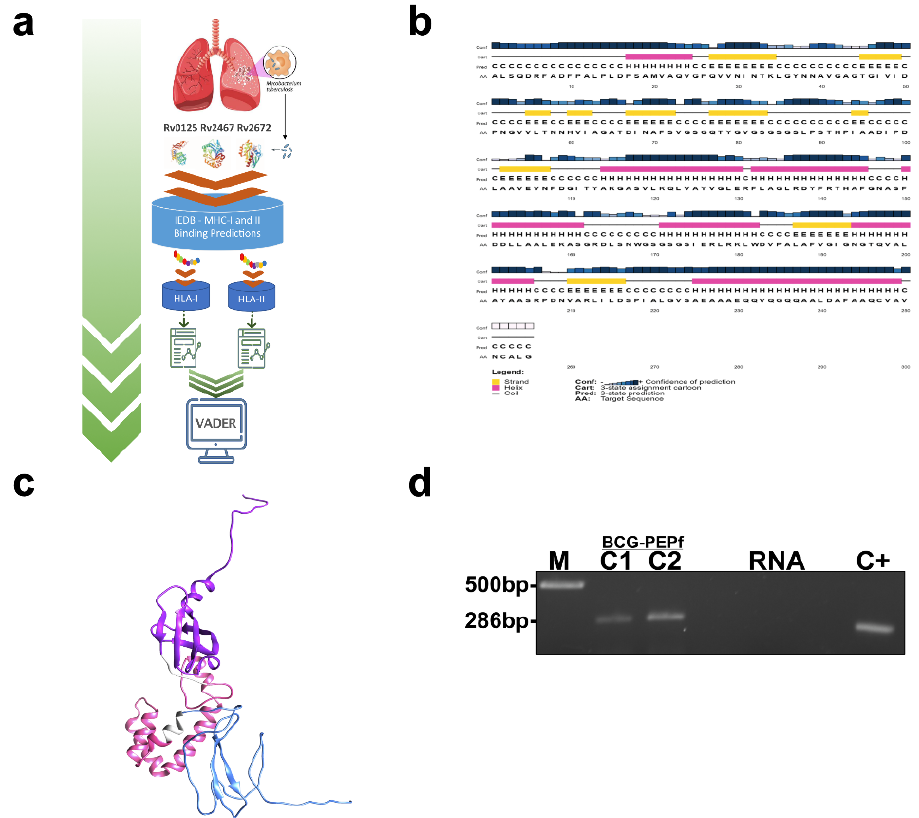
Figure 1. Construction of the PEPf fusion protein and its expression by live vaccines. ( a ) Prediction of HLA-I and -II binding epitopes and fusion protein design using the IEDB (Immune Epitope Database) and VADER (Vaccine-Associated Density Epitope Research) software. ( b ) PEPf is com- posed of 33% alpha-helices, 29% beta-sheets, and 37% loops. Yellow rectangles represent be- ta-sheets, pink rectangles represent the alpha-helices, and lines show the protein loops. ( c ) Tertiary structure of PEPf obtained using RaptorX and further refined using Galaxy Refine. ( d ) Expression of the recombinant fusion protein by the recombinant live vaccine, confirmed by extracting RNA from two recombinant BCG-PEPf clones (C1 and C2). The transcribed cDNA was amplified using specific primers for pepf flanking sequences. A plasmid carrying the fusion gene was used as a positive control (C+), and a cDNA synthesis reaction containing no reverse transcriptase (RNA) was used as a negative control. Lane M corresponds to 1 kb ladder from Sinapse Inc. (only the last band corresponding to 500 bp is shown). 3.2. PEPf Protein Used as a Subunit Vaccine Is Immunogenic in the Murine Vaccination Model Recombinant purified PEPf protein was obtained after expression in E. coli , and its immunogenic capacity was assessed by using a previously published subunit vaccine scheme with Advax4 as an adjuvant [31]. Fifteen days after the last immunization, the presence of CD4 + and CD8 + T cells specific for the PEPf protein were evaluated in the draining